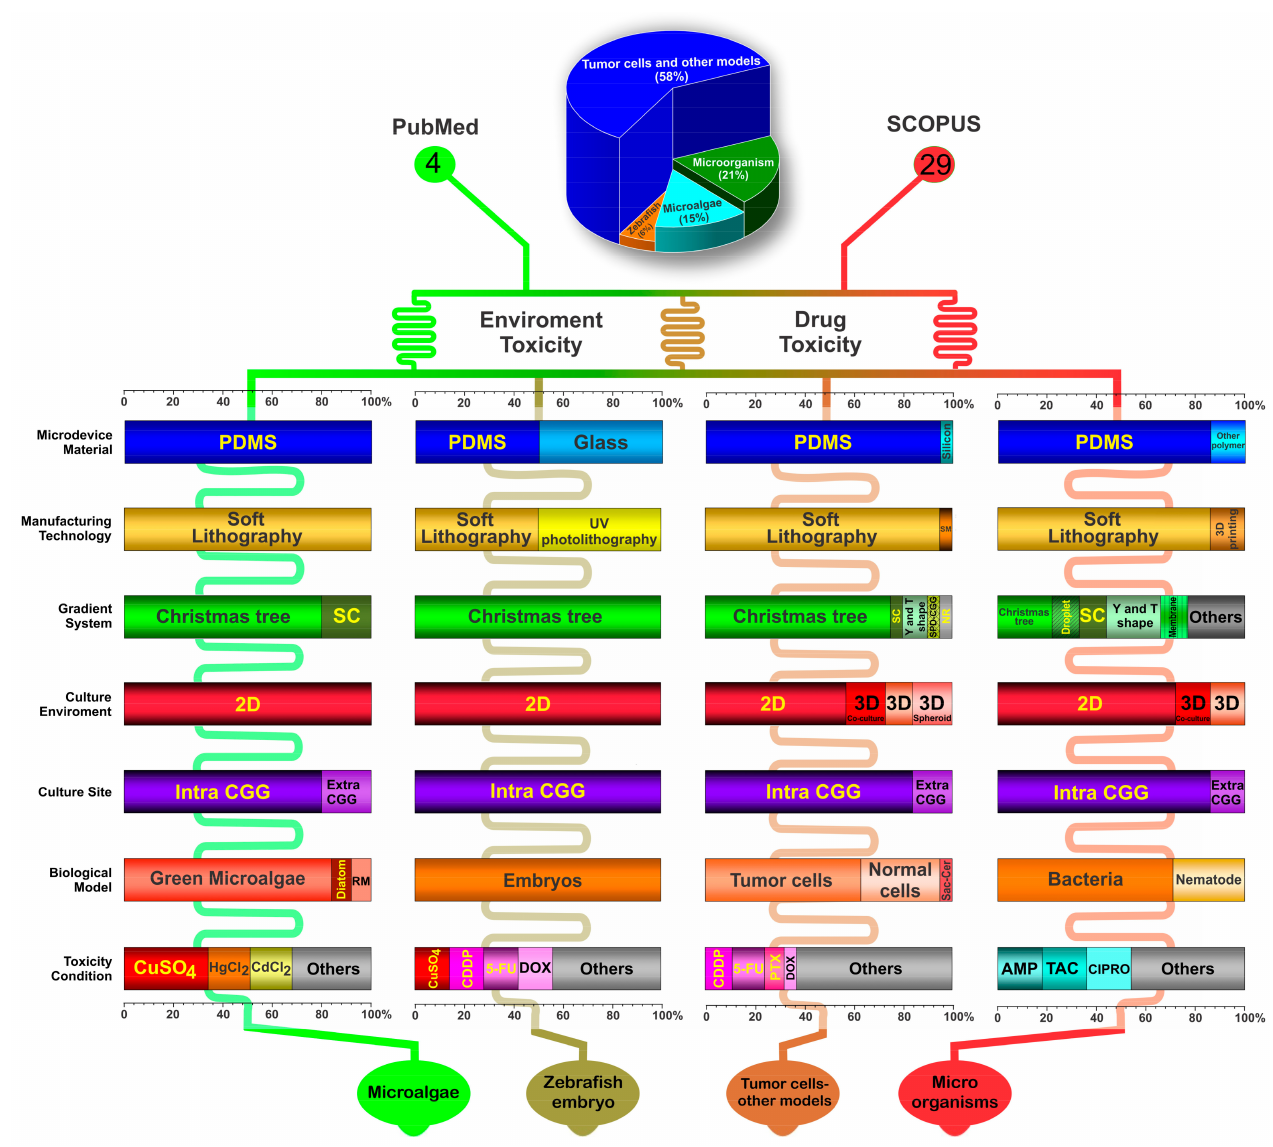
Figure 3. The systematic review identified 4 main types of organisms used for toxicity analysis using the CGG system in microfluidic devices: microalgae, zebrafish embryo, tumor cells and other models, and microorganisms. The figure shows the main important aspects (as percentages) regarding the microfluidic device material, manufacturing technology, gradient system, culture environment, culture site, biological model, and toxicity condition. Abbreviations: PDMS: